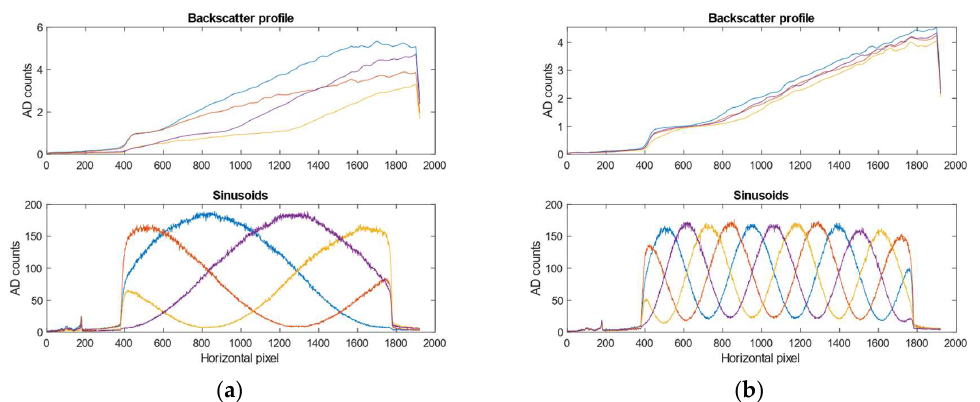
Figure 3. Backscatter profiles at turbidity with an attenuation length of λ 2 = 1.1 m. ( a ) 1-period pattern. ( b ) 4-period pattern. The lower plots show the projected sinusoidal signal, while the upper plots show the backscatter profile. The colors correspond across sinusoids and the backscatter profile, e.g., the blue sinusoid corresponds to the blue backscatter profile. Notice how the profiles are dependent on the illumination profile for low frequencies. At higher frequencies, the illumination profile is more uniform and the backscatter profile for each is more constant across the shifted signals.